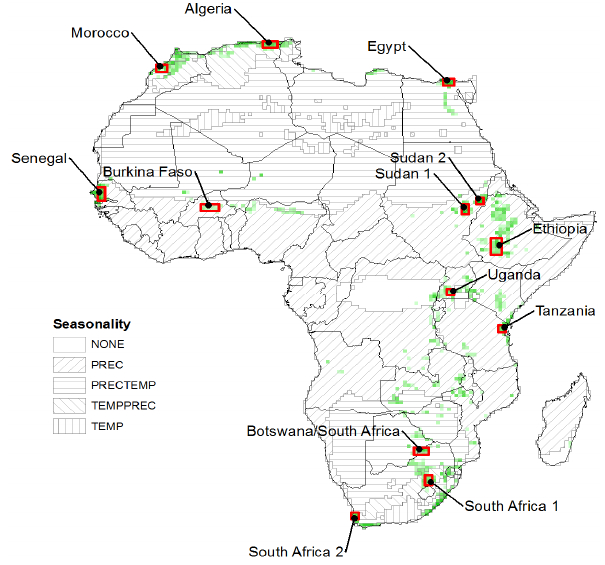
Fig. 2. Location of selected cropland areas. Cells with cropland fractions > 25% are indicated in green. The climate seasonality types for 1990 used for sowing date calculation by LPJ-GUESS are indicated by hatched grey. The two Sudan crop regions are treated as a single region in the text. The seasonality types are defined in the Methods